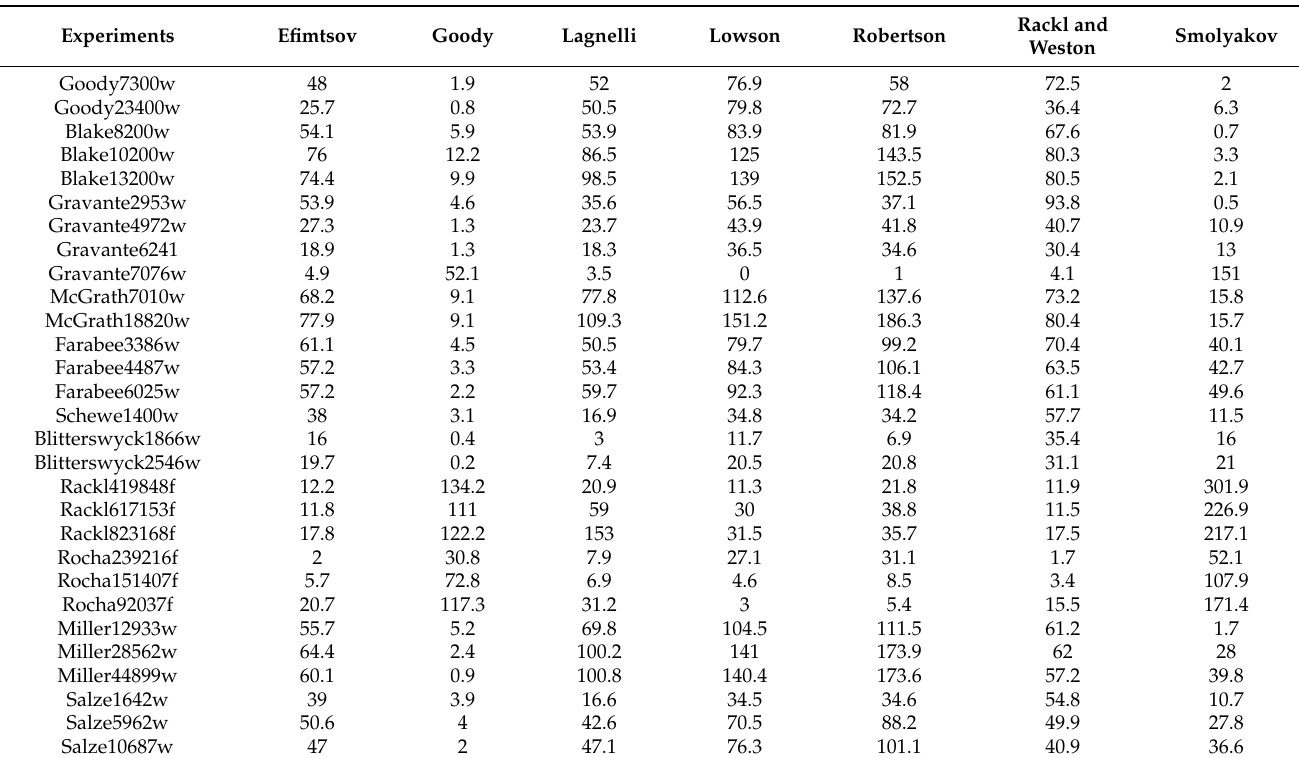
Table A5. Spectrum mean squared error for the medium frequency